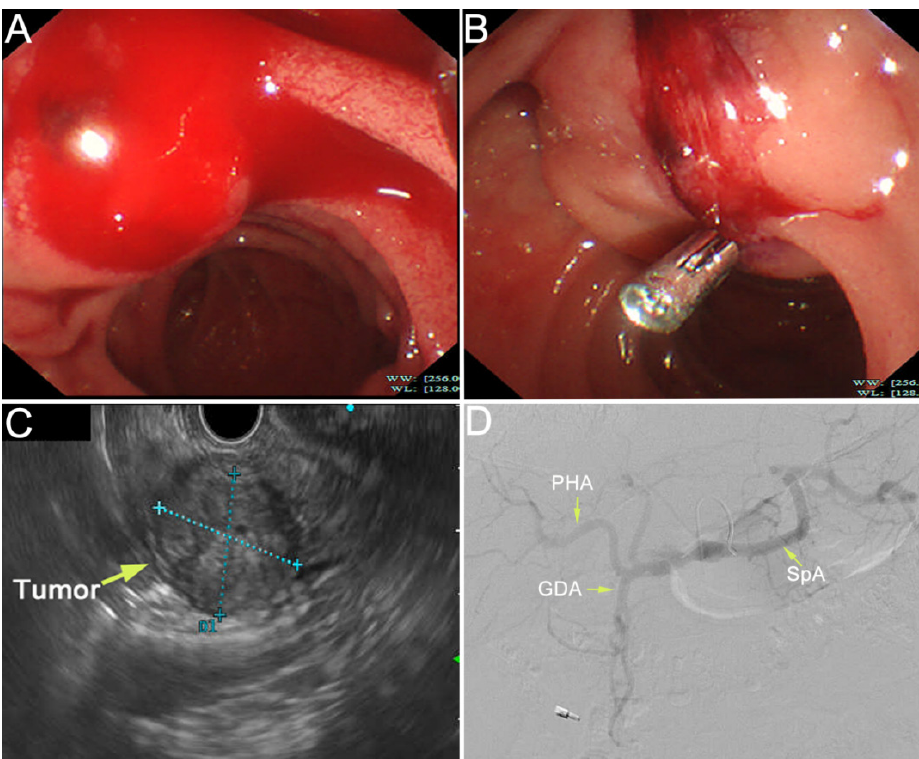
Figure 1. Enhanced upper abdominal computed tomography (CT) performed in the local hospital indicated ampullary mass. ( A ): plain scan phase; ( B ): arterial phase; ( C ): venous phase; ( D ): delayed phase. A 59 ‐ year ‐ old male patient was hospitalized for “recurrent hematochezia for 8 days”. En ‐ hanced upper abdominal computed tomography (CT), performed in the local hospital, indicated ampullary mass. On CT, the tumor showed uneven enhancement in the arterial phase, but the en ‐ hancement significantly weakened in the venous phase and delayed phase. Therefore, this imaging feature was significantly different from that in the primary ampullary tumor or pancreatic tumor. Duodenoscopy revealed duodenal papilla hemorrhage. Urinalysis showed no hematuria. After conservative treatment, the hemorrhage was not resolved. Then, the patient was transferred to our hospital for further treatment. He had received radical nephrectomy due to clear cell renal cell carcinoma (ccRCC) of the left kidney 16 years ago. The CT scan mentioned above revealed that his right kidney was normal. On admission, his laboratory tests results were as follows: leukocyte count of 3.9 × 10 9 /L; neutrophilic granulocytes percentage of 75%; C-reactive protein of 1.6 mg/L; hemoglobin of 102 g/L; total bilirubin concentration of 12.6 µ mol/L; alanine aminotransferase of 16 U/L; aspartate aminotransferase of 19 U/L.